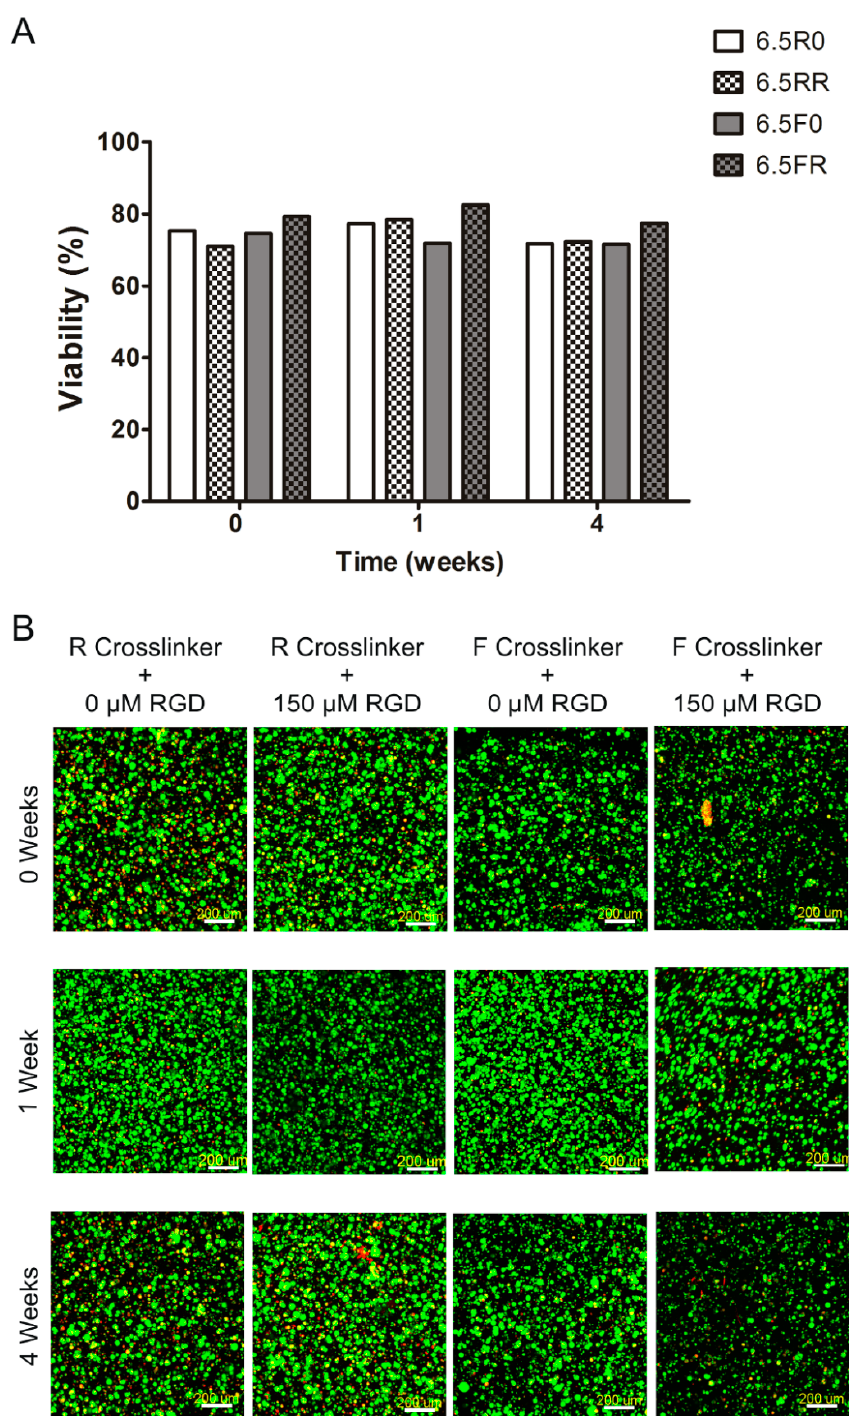
Figure 6. ATDC viability within protease sensitive 6.5% ( w / v ) PEG-VS hydrogels, with different cross-linkers (F or R) as well as with and without RGD, cultured over time. Constructs were examined at 0 weeks (24 h in MM) and 1 and 4 weeks in the 4C chondrogenic differentiation medium. 6.5R0 = R cross-linker + 0 µ M RGD; 6.5RR = R cross-linker + 150 µ M RGD; 6.5F0 = F cross-linker + 0 µ M RGD; 6.5FR = F cross-linker + 150 µ M RGD. ( A ) IMARIS software based quantification of viability percentages of ATDC5 cells encapsulated in PEG hydrogels ( n = 1; values depicted are the averages of two different measured areas within one sample). ( B ) Representative confocal images of Live/Dead staining shown as the maximum intensity of a 500 µ m z-stack where live cells are green and dead cells are red (scale bar = 200 µ